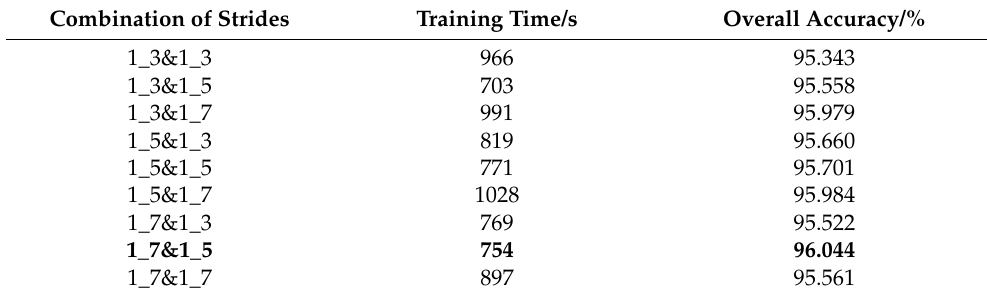
Table 4. Accuracy and training time for different stride combinations on the Pavia University dataset.